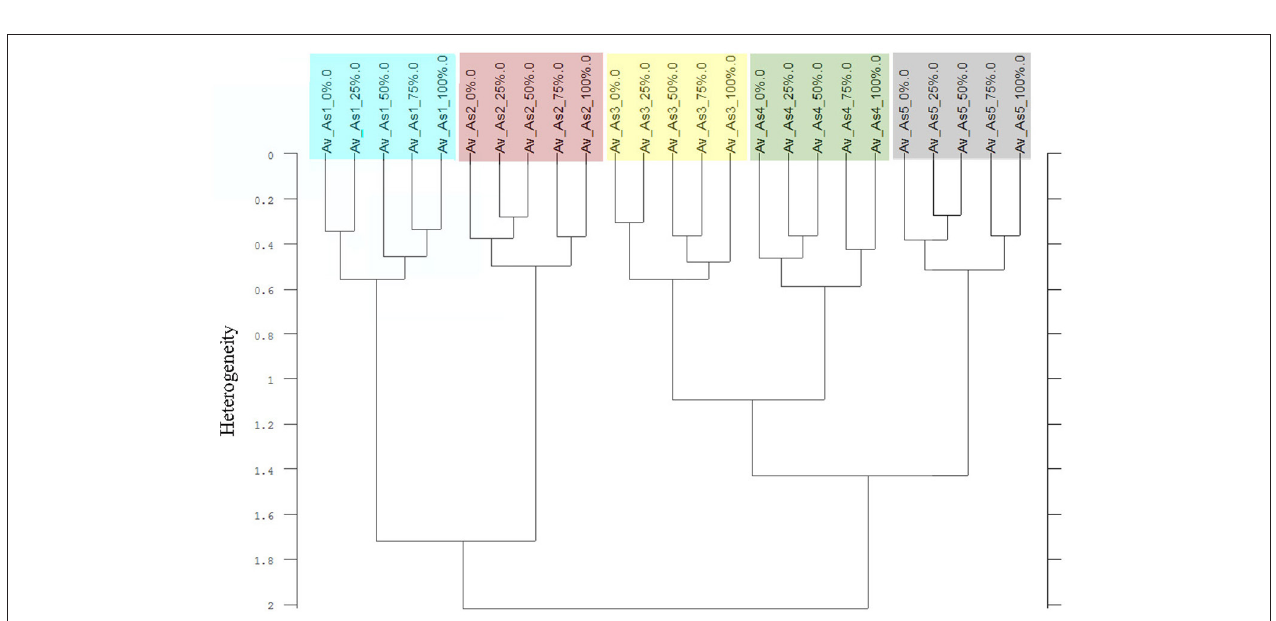
FIGURE 9 | Cluster analysis of the Av-spectra of all cultivars of the species Avena sativa (As, oat) for the experiment 1-1. The complete frequency range (3,997–374 cm − 1 ) of the Av-spectra was evaluated with the second derivation and vector normalization, Ward’s algorithm und Euclidian distance. The Av-spectra are averages (Av) of FTIR-ATR spectra of the different root segments (100% root tip, 0% root basis etc.; see Figure 1 for scheme, Table 2 for n, Table 1 for names of cultivars and proveniences).